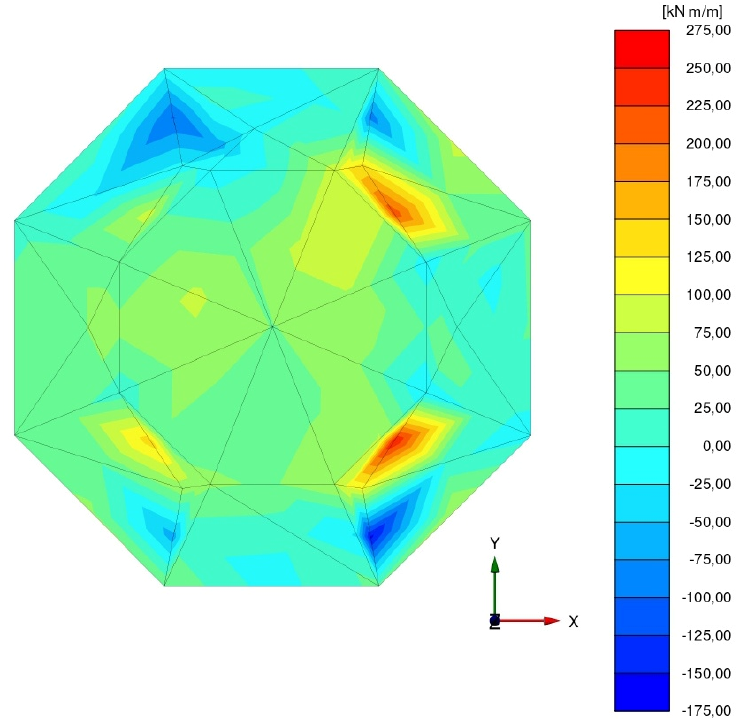
Figure 29. Bending moments along the plate at the end of the dynamic phase using the 1693 seis- mic